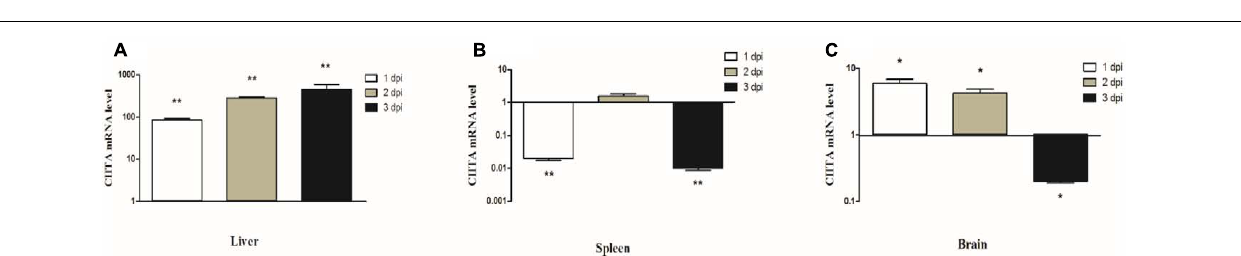
there was no significant change in the IL-1 β mRNA